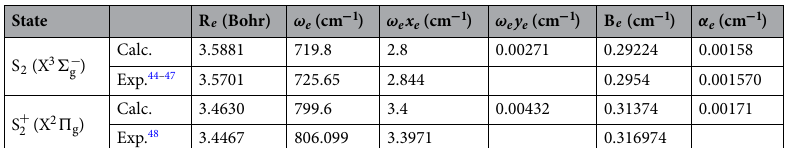
+ 2 (cid:31) g ). The constants 2 (X